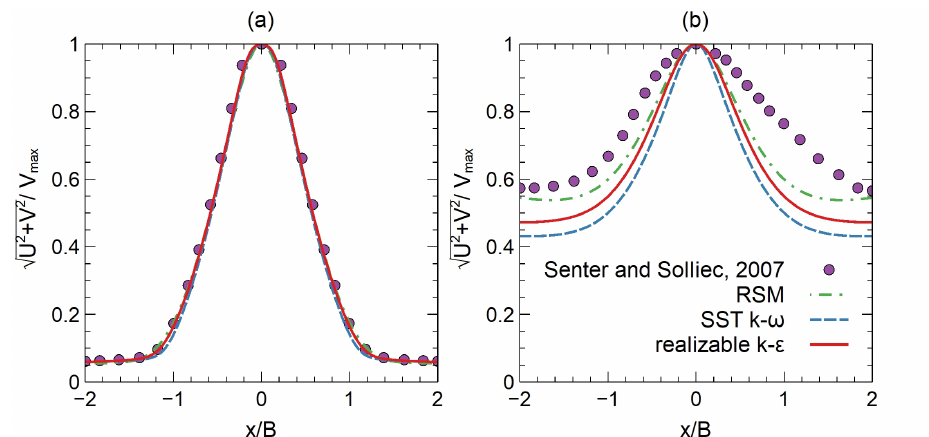
Figure 10. Normalized velocity magnitude between − 2 < x / B < 2 for H / B = 8 at ( a ) y / B = 4 and ( b ) y / B = 1, compared to reference results reported by Senter and Solliec [70]. It is notable that the velocity profile at y / B = 1 was wider than at y / B = 4, since the further it was from the impingement plate, the smaller its effect on the jet